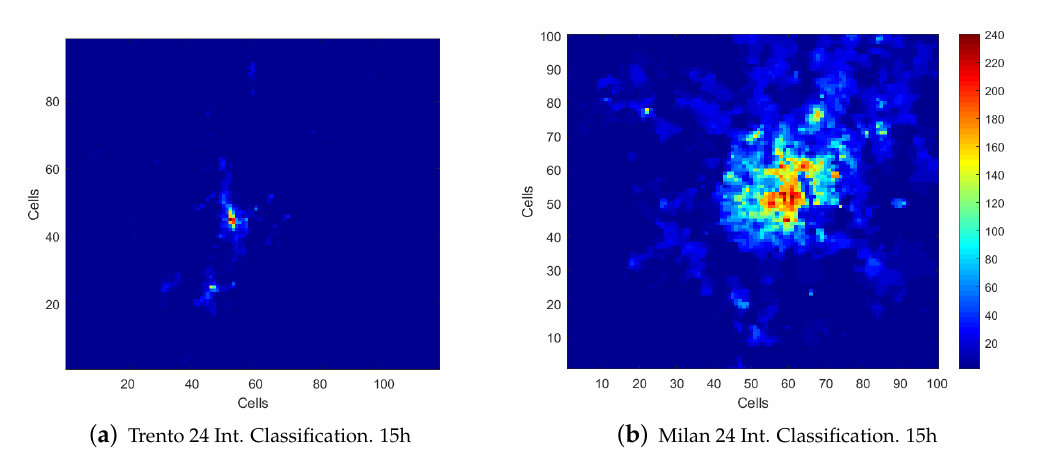
Figure 5. Heat map representation of the network usage at 15:00 h. ( a ) The classification made to the Trento province data set using the unified vectors. ( b ) The classification performed to the Milan data set using the same unified classes. Both data sets are grouped hourly.